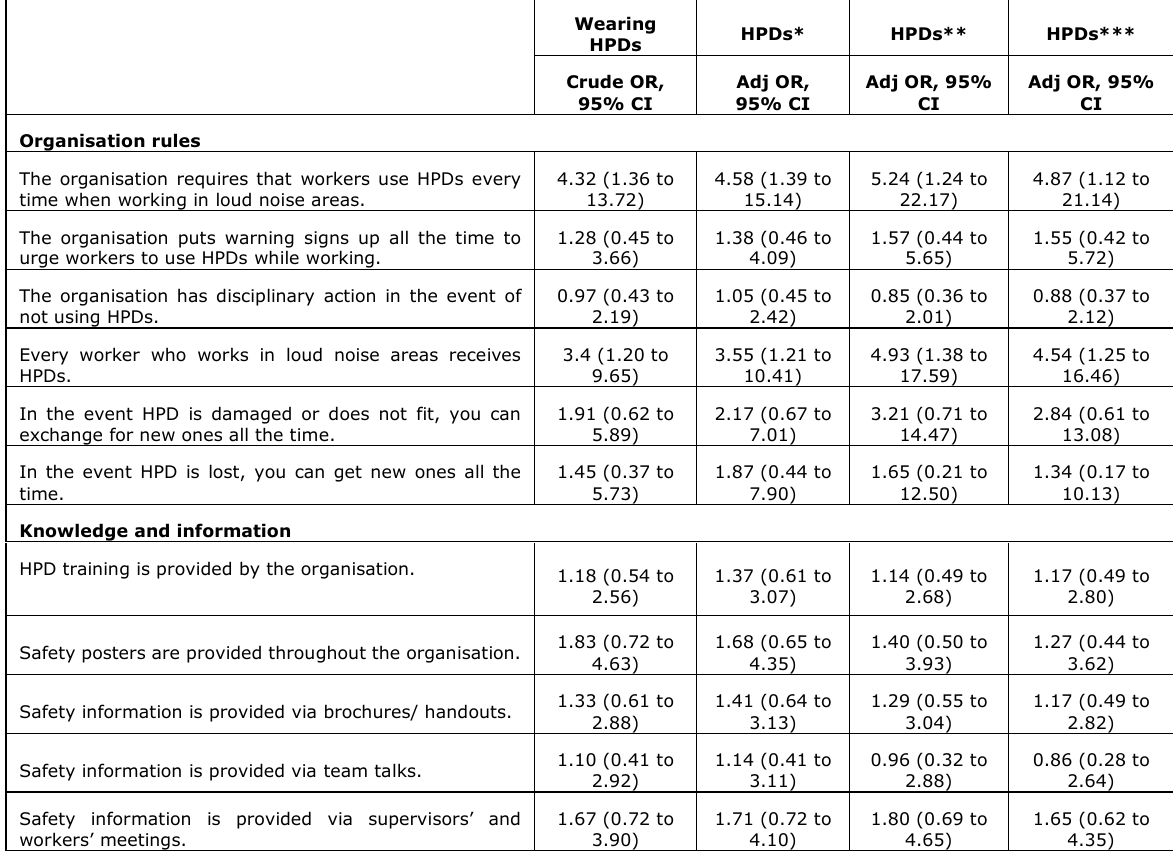
Table 4. Association between wearing HPDs and workers personal